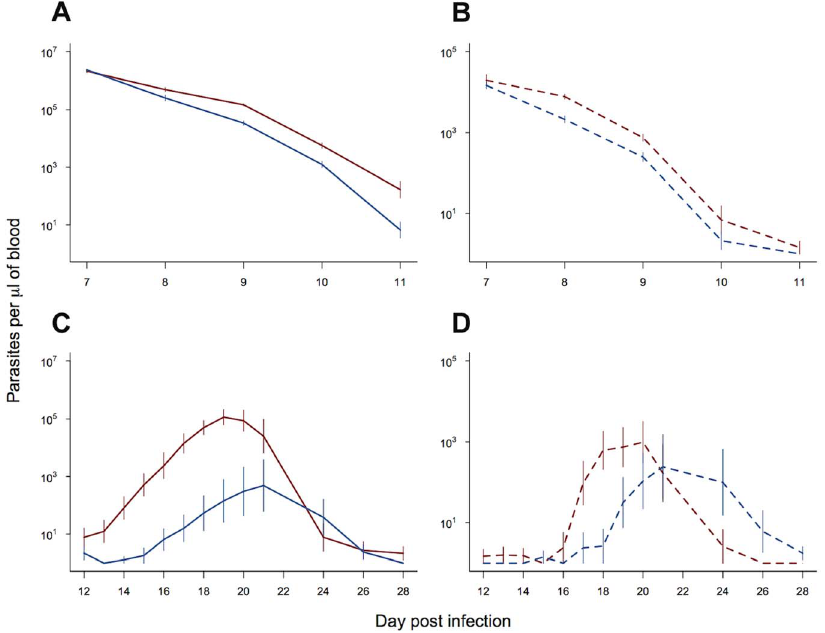
Figure 3. Transmission advantage of selected line. Asexual (solid lines) and gametocyte (dashed lines) density during the period of drug treatment (a & b) and post drug treatment (c & d). Selected line is shown in red and control line in blue. As treatment time had no significant effect on parasite dynamics, means and standard errors are calculated from pooled data (10 replicate infections per line). Bars show the standard error of the mean. Data from experiment 2. p , 0.0001; drug dose x 2 24,558, =203.43, p , 0.0001; figure 4c) and gametocyte densities (day*drug treatment x 2 49,558 =321.4,